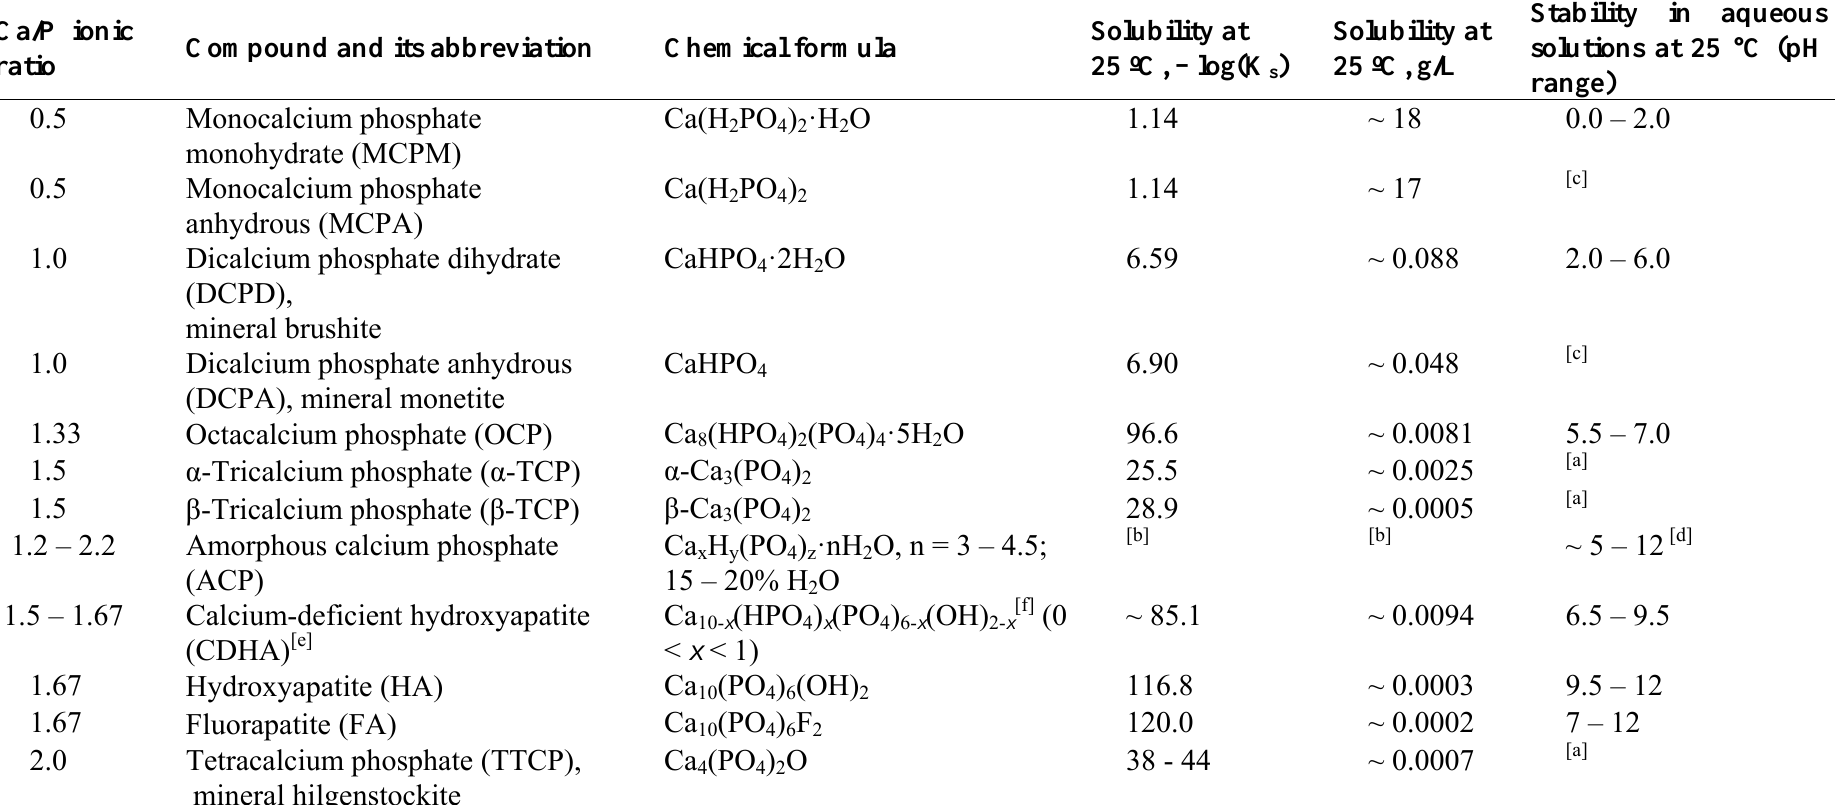
Table 1. Existing calcium orthophosphates and their major properties